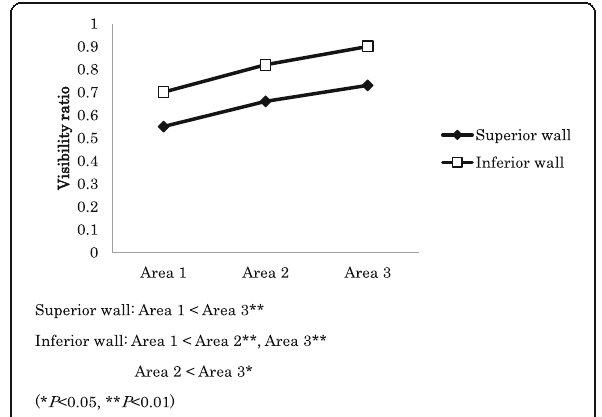
Fig. 3 Visibility ratios of the superior and inferior walls in three areas. The Friedman test and Scheffe ’ s test were used for the statistical